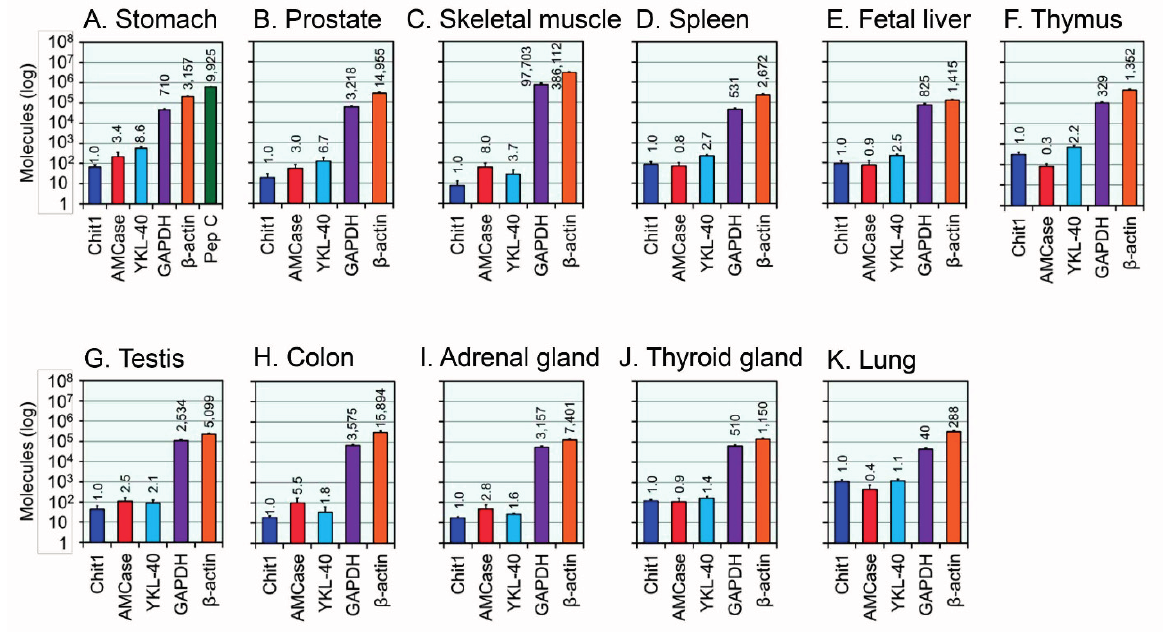
Figure 5. Human tissues with expression levels of YKL-40 similar or less than 10-times higher than those of Chit1. Expression analysis of six genes in stomach ( A ) and five genes in prostate ( B ); skeletal muscle ( C ); spleen ( D ); fetal liver ( E ); thymus ( F ); testis ( G ); colon ( H ); adrenal gland ( I ); thyroid gland ( J ) and lung ( K ) tissues using qPCR. All values are expressed as number of molecules per 10 ng of total RNA in y axis. Logarithm of each value is shown. The expression level of Chit1 was set to 1.0; the values above bars indicate the relative expression levels compared to Chit1. Human tissue samples were pooled from 1–64 Caucasians: stomach, n = 1; prostate, n = 12; skeletal muscle, n = 2; spleen, n = 12; fetal liver, n = 63; thymus, n = 2; testis, n = 39; colon, n = 1; adrenal gland, n = 62; thyroid gland, n = 64; lung, n =